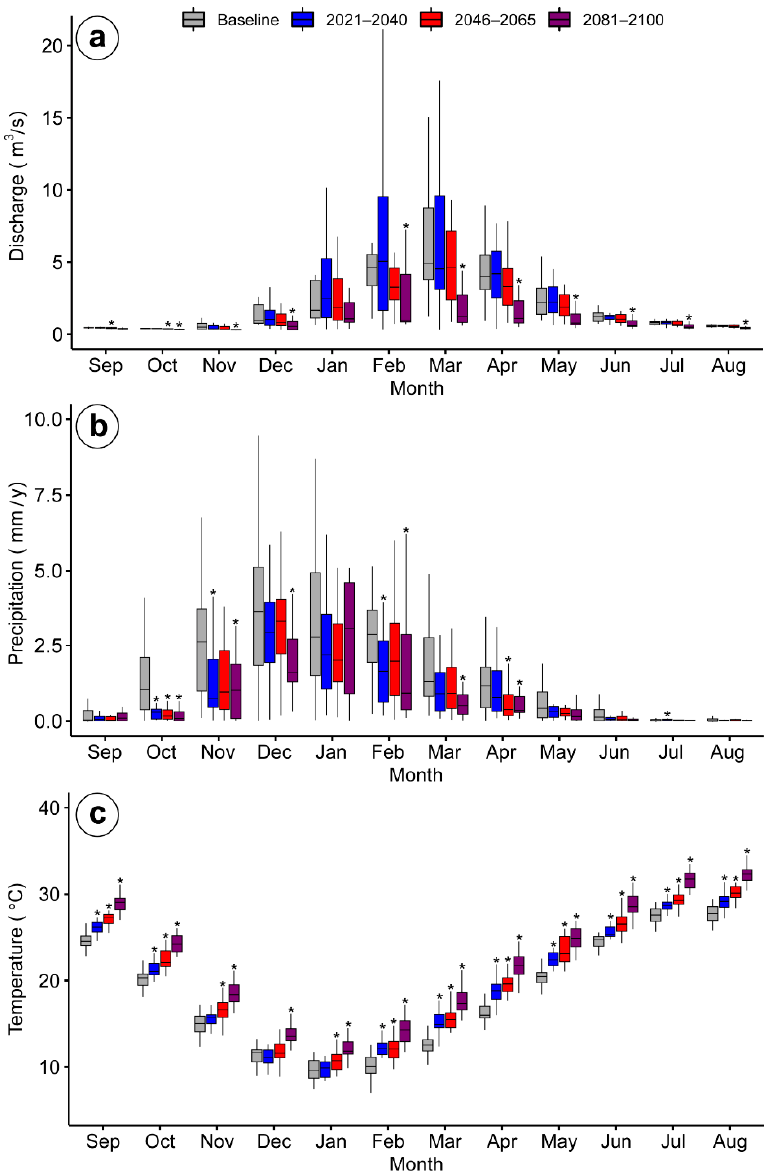
Figure 9. Boxplot representation and Wilcoxon rank-sum test results for ( a ) discharge, ( b ) precipi- tation and ( c ) temperature during the three future periods. The stars indicate the month where the significance level ( p ≤ 0.05) was achieved.